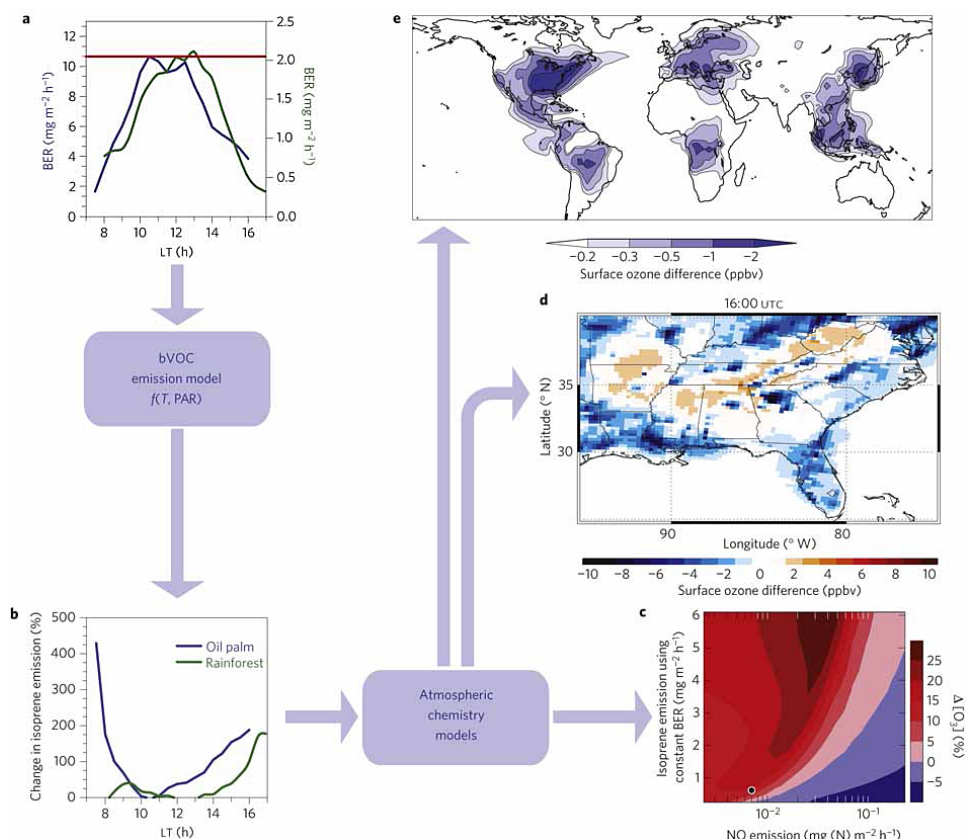
Figure 32. The effect of a circadian rhythm based biogenic emission rate (BER) on ozone. (a) The oil palm plantation (blue) and rainforest (green) BERs of isoprene compared with a constant BER (red). (b) The differences in isoprene emission rates between constant (red line in a ) and circadian-controlled BERs (oil palm: blue; rainforest: green). (c) Changes in ground-level ozone resulting from changing isoprene and nitrogen oxide emission rates. (d) Changes in regional-scale modelled ground-level ozone for 11:00 LT using an “oil palm” circadian- controlled BER compared with a constant BER. (e) Changes in global-scale modelled ground-level ozone for July using the same scenario as (d) (Hewitt et al.,